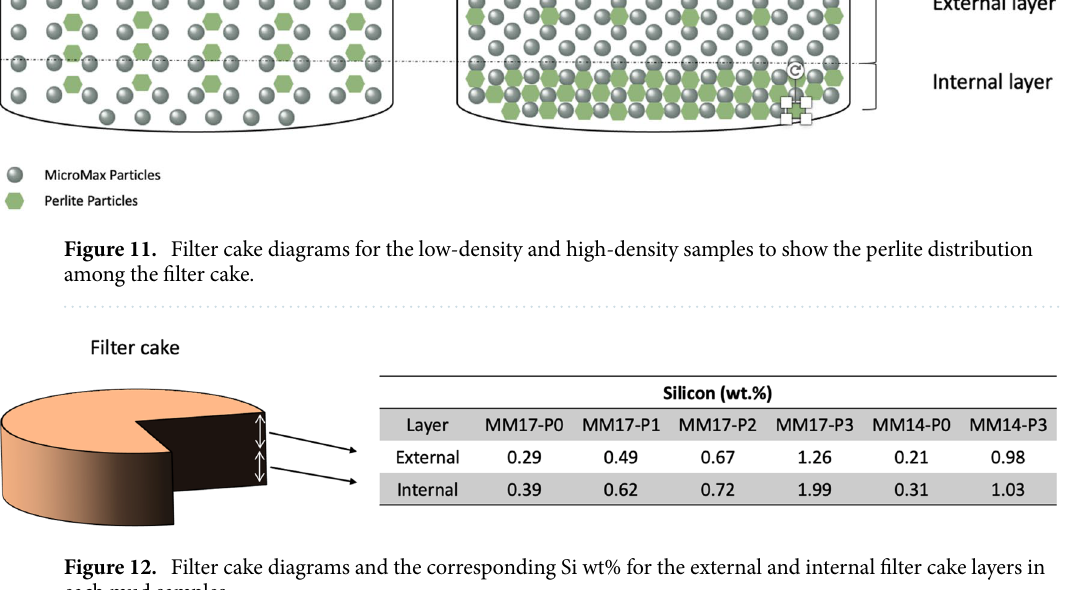
Figure 12. Filter cake diagrams and the corresponding Si wt% for the external and internal filter cake layers in each mud